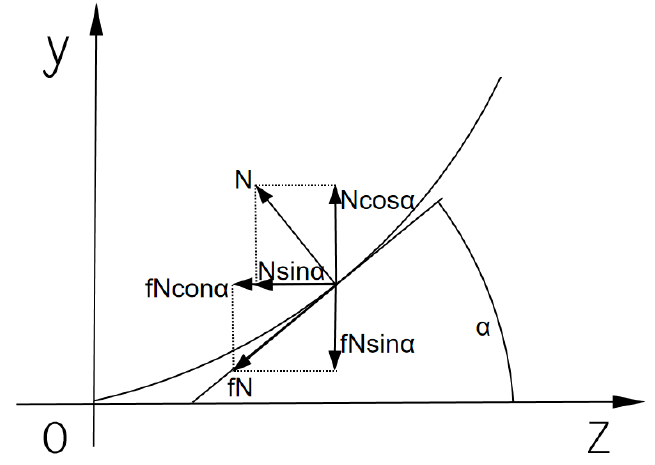
Figure 4. Driving edge force N and friction force fN.